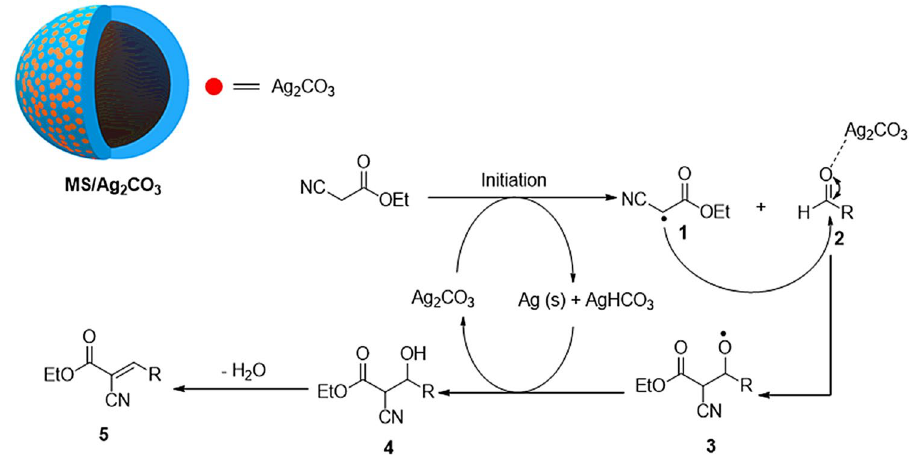
Figure 8. Proposed mechanism for the Knoevenagel condensation using the MS/Ag 2 CO 3 catalyst.